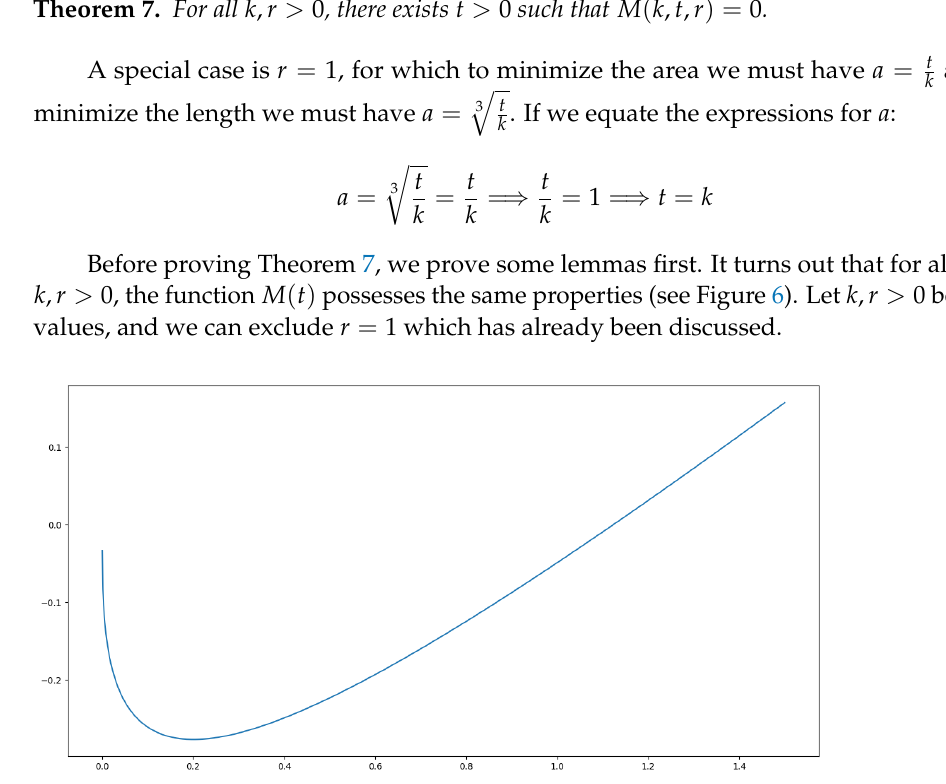
Figure 6. A graph of M ( t ) with k = 1 and r = 2. M ( t ) appears to be continuous, strictly convex, negative at a right neighbourhood of t = 0, and seems to approach + ∞ as t → + ∞